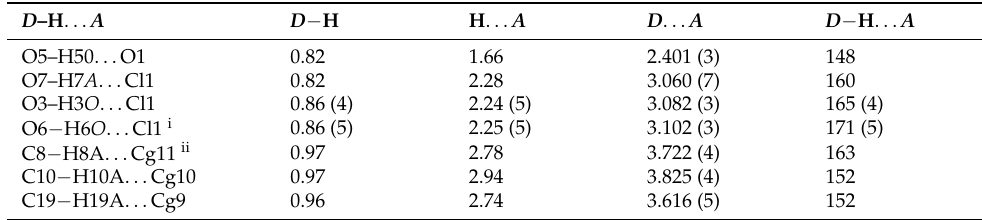
Table 4. Hydrogen-bond geometry (Å, ◦ ) for the [Ni 2 HL 2 (EtOH) 2 ](Cl)(EtOH) complex. D –H . . .